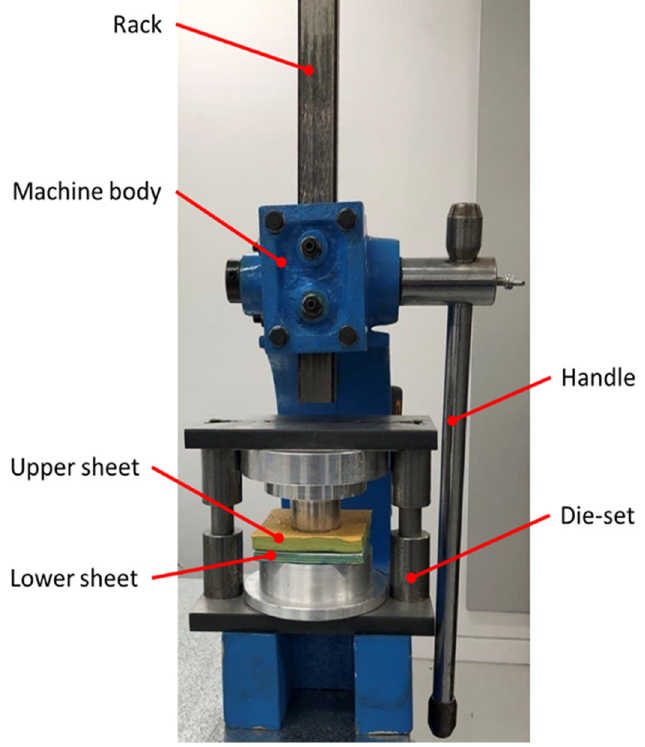
Figure 6. Scaled-up clinching die-set set up mounted in a manual press.